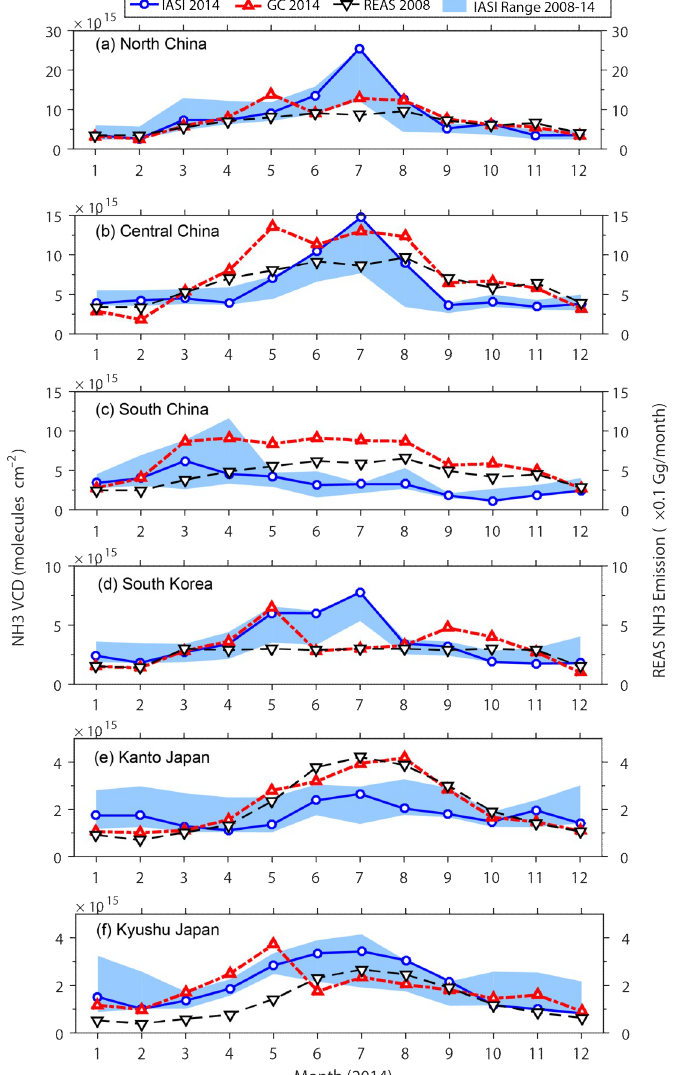
Figure 4. Regional averaged monthly IASI NH 3 VCD (the blue dashed line with open circle and shade), GEOS-Chem NH 3 VCD (the red dashed line with the open triangle), and REAS NH 3 emissions (the black dashed line with the open triangle). ( a ): North China, ( b ): Central China, ( c ) South China, ( d ) South Korea, ( e ) Kanto Japan, ( f ) Kyushu Japan.